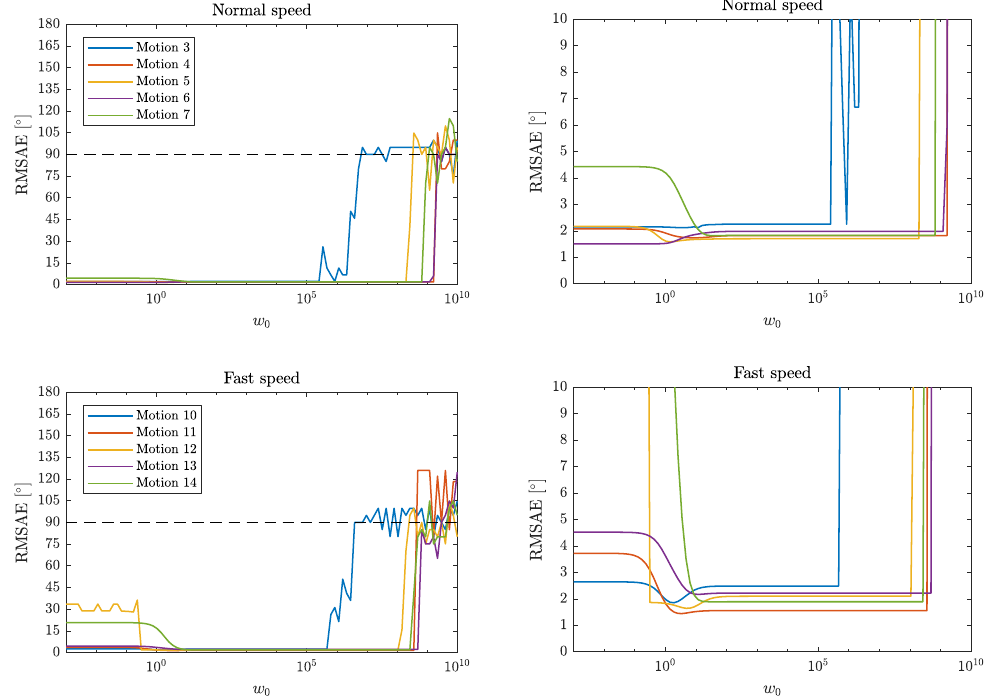
Figure 5. Root-mean-square angular error (RMSAE) (71) for different motions and weights w 0 . Normal speed motions are shown in the top plots and faster motions are shown in the bottom plots. The plots on the right show the same results as the plots to their respective lefts, but zoomed